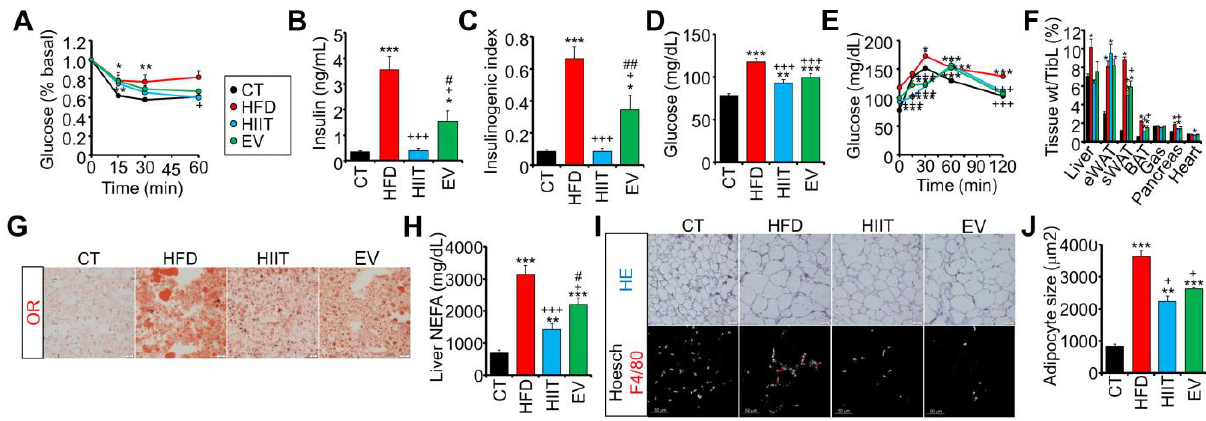
Figure 4. Treatment with EV-miRNAs improves hepatic insulin sensitivity and steatosis: ( A – C ) Both HIIT and EV improved the insulin sensitivity of obese mice as measured by an insulin tolerance test ( A ), decreased fasting insulinemia ( B ), and lower insulinogenic index ( C ). ( D ) Both the HIIT and EV groups showed lower glycemia after a long fast than untreated HFD mice. ( E ) Pyruvate tolerance test showed lower gluconeogenesis in HIIT and EV mice as compared to untreated HFD mice. ( F ) Postmortem tissue analysis evidenced decreased liver and sWAT weight in the HIIT and EV groups. ( G , H ) Untreated HFD mice showed high levels of hepatic steatosis as determined by Oil Red O staining ( G ) and the quantification of liver non-esterified fatty acids ( H ). Scale bars represent 20 µm. These parameters were partially decreased by both HIIT and EV treatments. ( I , J ) HIIT and EV treatments partially reduced adipocyte size as determined by hematoxylin and eosin staining in the sWAT ( I (upper panels), J ) and decreased F4/80 macrophage infiltration ( I (lower panels)). Scale bars represent 50 µm. n = 6/group ( A – F ), n = 2/group ( G – J ); * p < 0.05, ** p < 0.01, *** p < 0.005 with respect to the CT group; + p < 0.05, +++ p < 0.005 with respect to the HFD group; # p < 0.05, ## p < 0.01 between the HIIT and EV